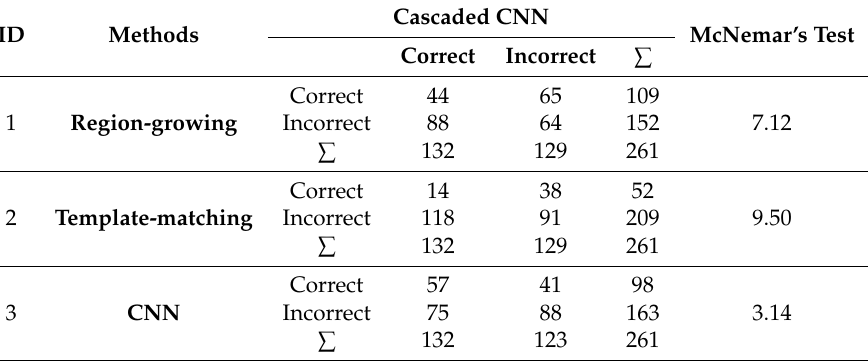
Table 7. The results of McNemar’s test in Test Area